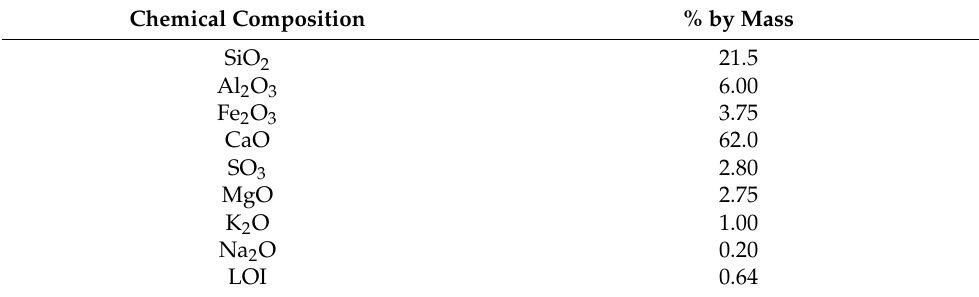
Table 2. Chemical composition of OPC.